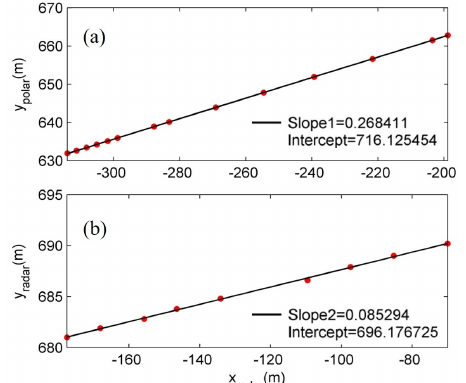
Figure 9. Straight line fitting calculation: (a) fitting using point set projected to radar imaging plane of linear structure; (b) fitting using pixels of linear structure in radar